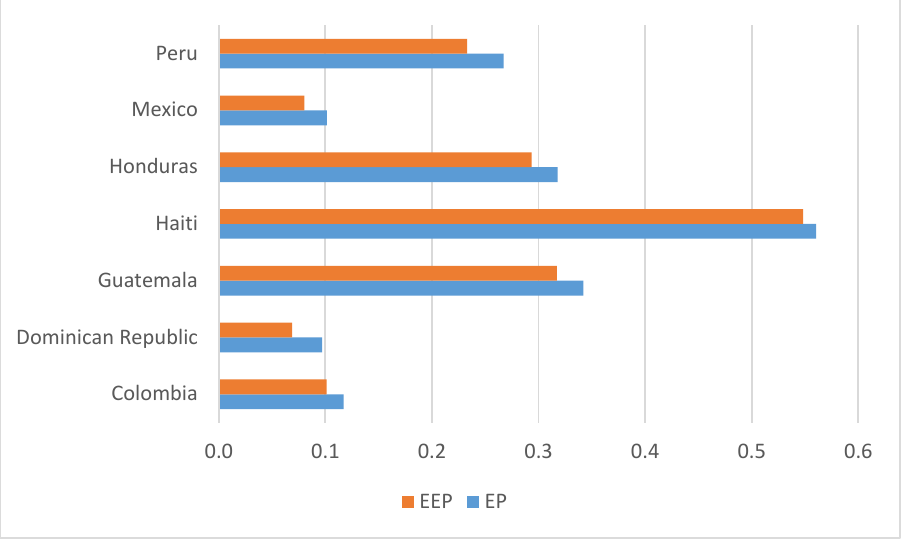
Figure 2. Multidimensional Energy Poverty Index for the evaluated countries.